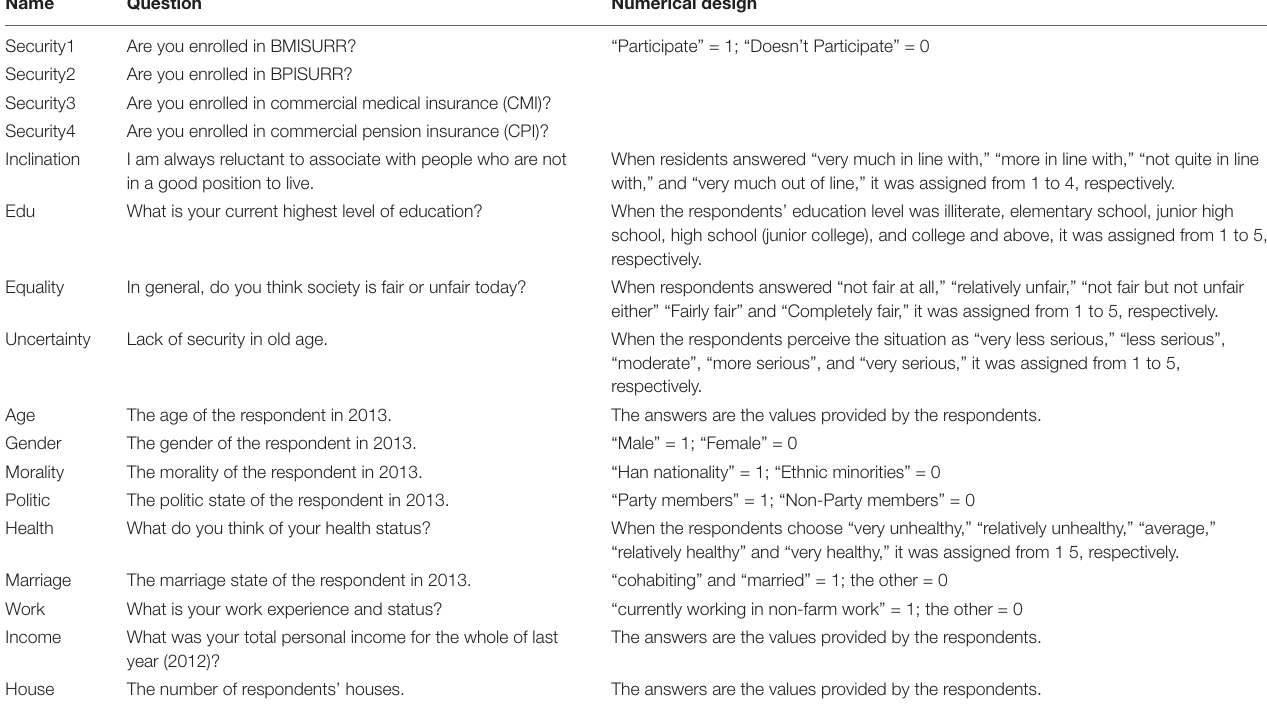
TABLE 2 | Main variables affecting social